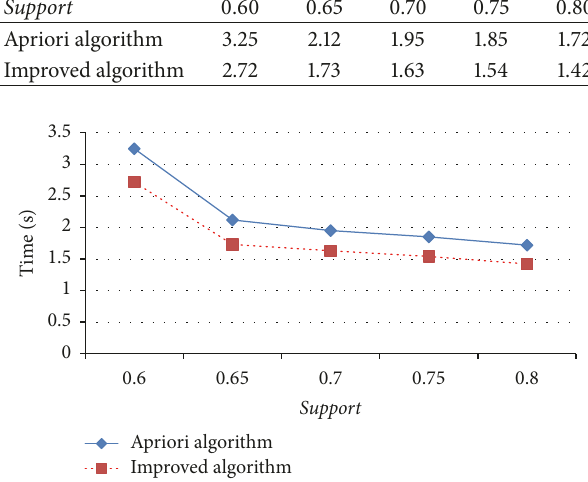
Figure 1: Runtime of the two algorithms on mushroom